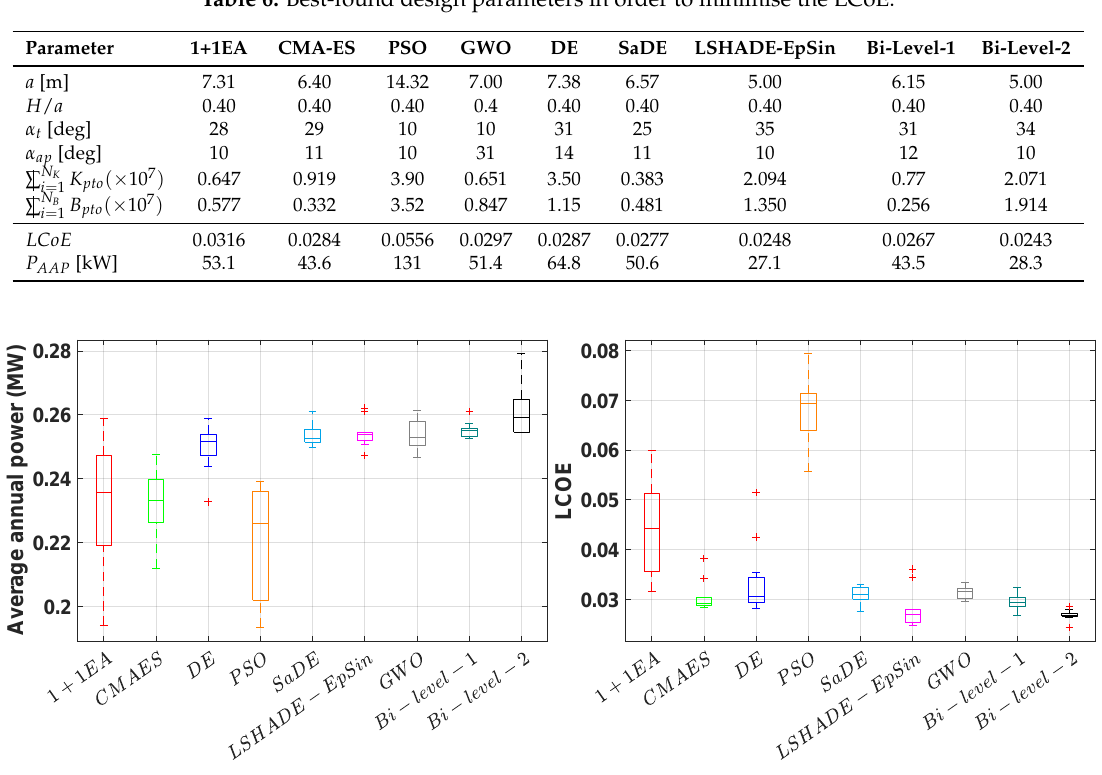
Table 6. Best-found design parameters in order to minimise the LCoE.